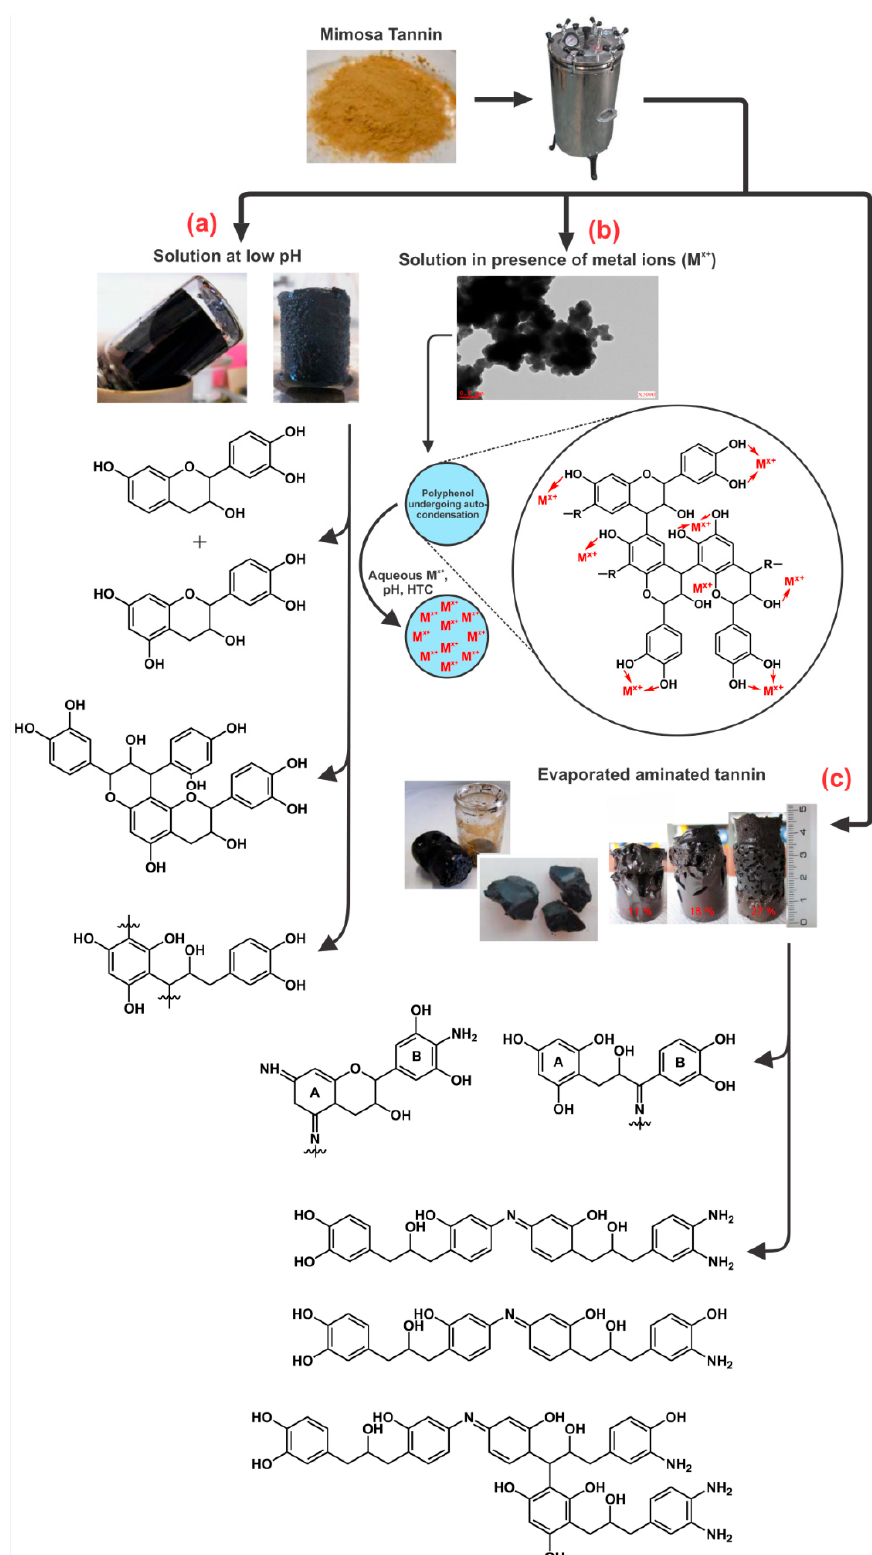
Figure 12. Gels prepared under hydrothermal conditions with aqueous tannin solution at low pH ( a ) (Reprinted with permission from reference [106]. Copyright 2015 Elsevier), with metal salts ( b ) [113], and with aqueous evaporated aminated tannin ( c ) [114].